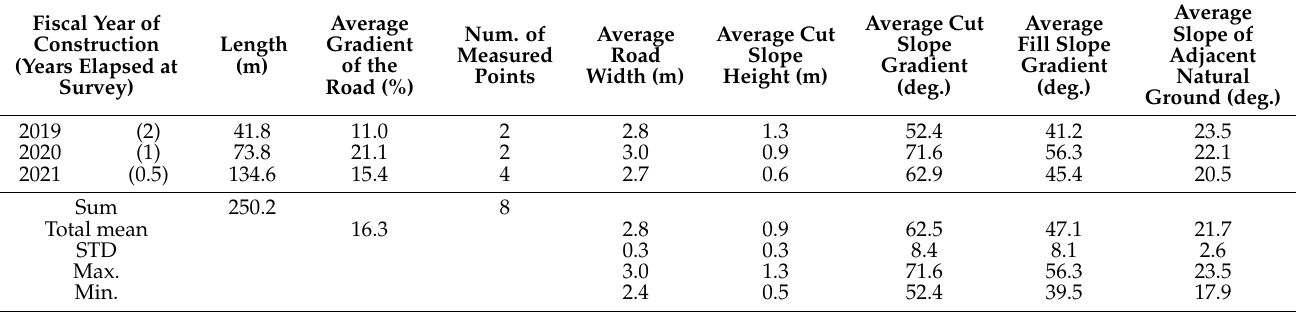
Table 2. Descriptive statistics of Study Site 2: a spur road in the east block of Kochi University